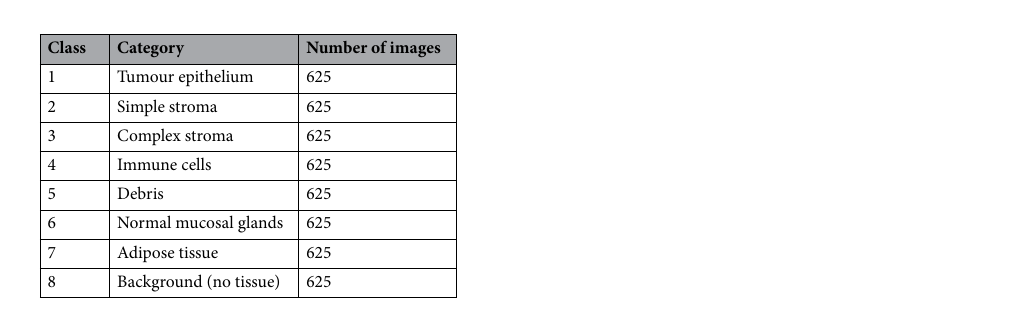
Table 9. Distribution of images in the Zenodo 5K dataset used for the additional test in this research.